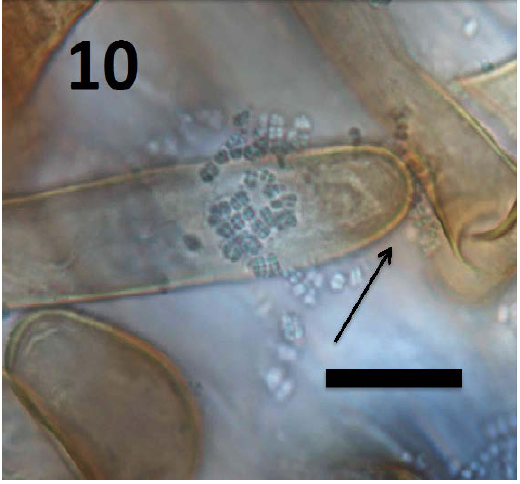
Figure 10. Root hair of Rumex crispus seedling showing tetrads of M. luteus (arrow) emerging from hair tip (bar = 20 µm; stained with 3,3-diaminobenzidine followed by aniline blue).